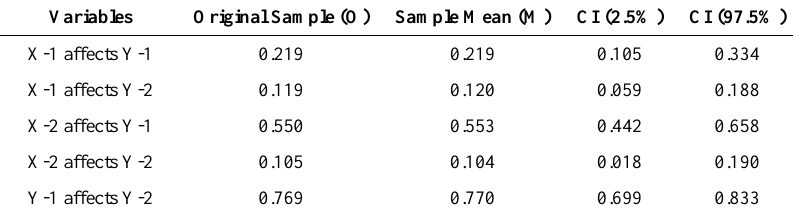
Table 2. Discriminant Validity Test Results (HTMT